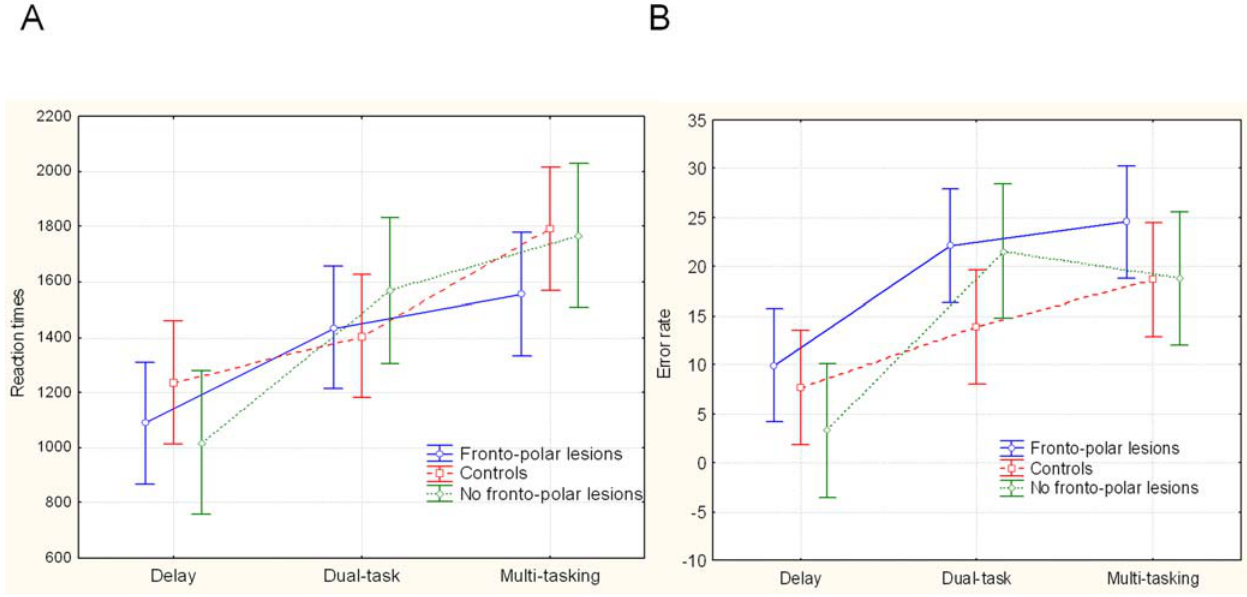
Figure 5. Behavioral performance. (A). Graph representing responses times (for correct responses) in patients with fronto-polar cortex lesions (blue), in patients without fronto-polar cortex lesions (green) and in controls (red). (B). Percentage of errors in the three conditions (delay, dual and multi-tasking) in patients with fronto-polar lesions (blue), in patients without fronto-polar cortex lesions (green) and in normal controls (red). Error bars represent the 95% confidence